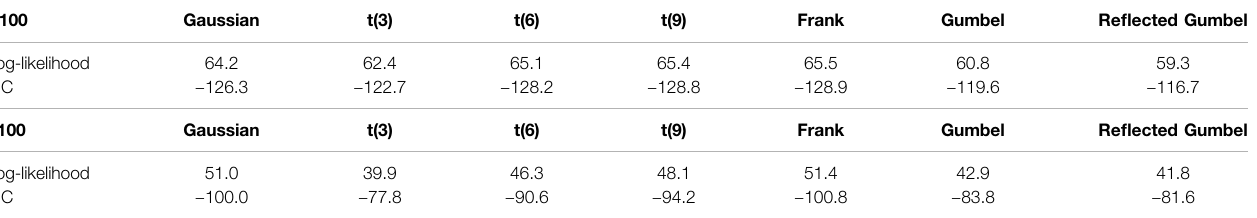
TABLE 4 | Model comparison for groups R100 and T100: the log-likelihood and AIC values based on different parametric copula models with fi xed univariate parameters/ distributions. The notation t( ν ) indicates the bivariate t copula with degree of freedom parameter ν . R100